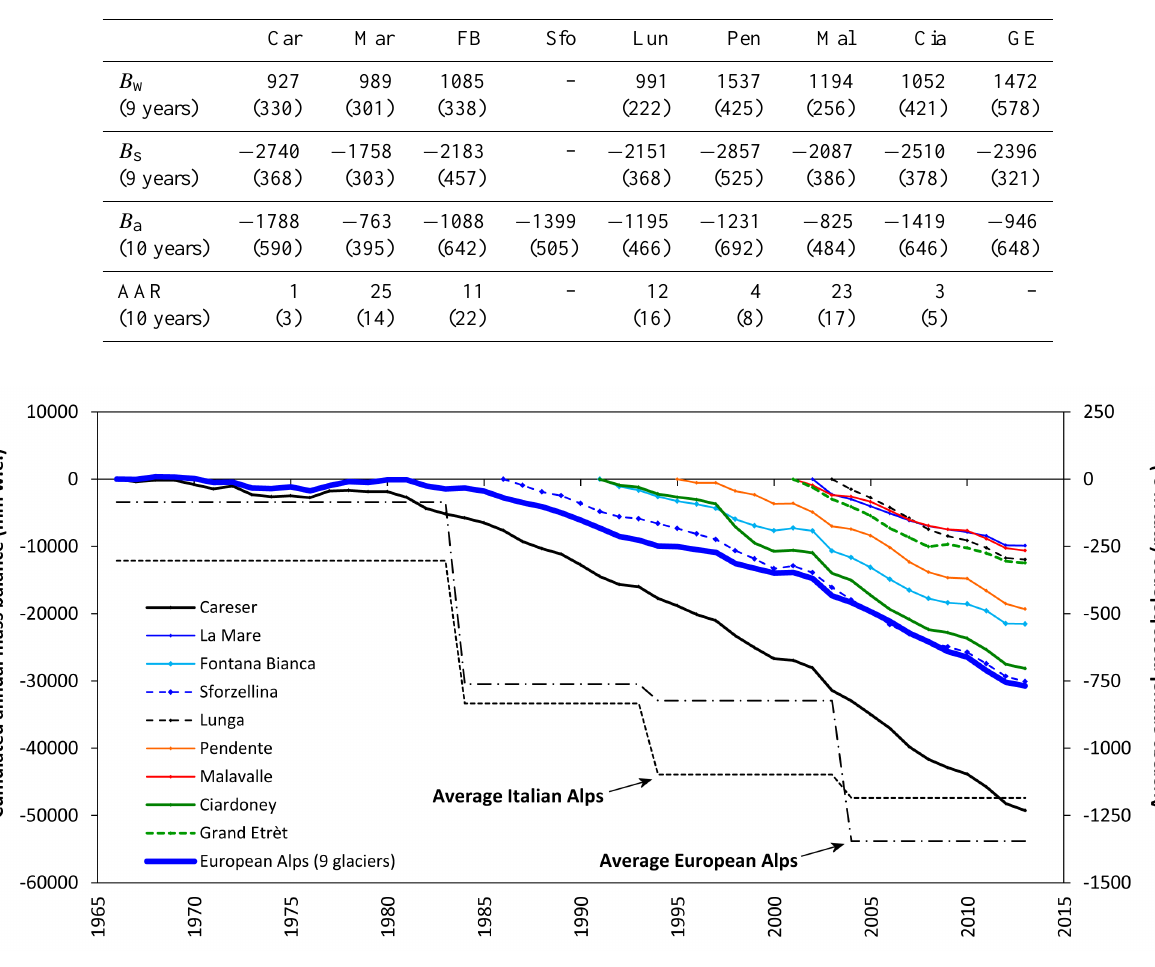
Figure 4. Cumulative mass balance for the nine Italian glaciers and for a set of nine other glaciers representative of the European Alps. Dotted and dashed lines indicate the average B a for the two groups of glaciers in the periods from 1967 to 1983, 1984 to 1993, 1994 to 2003 and 2004 to